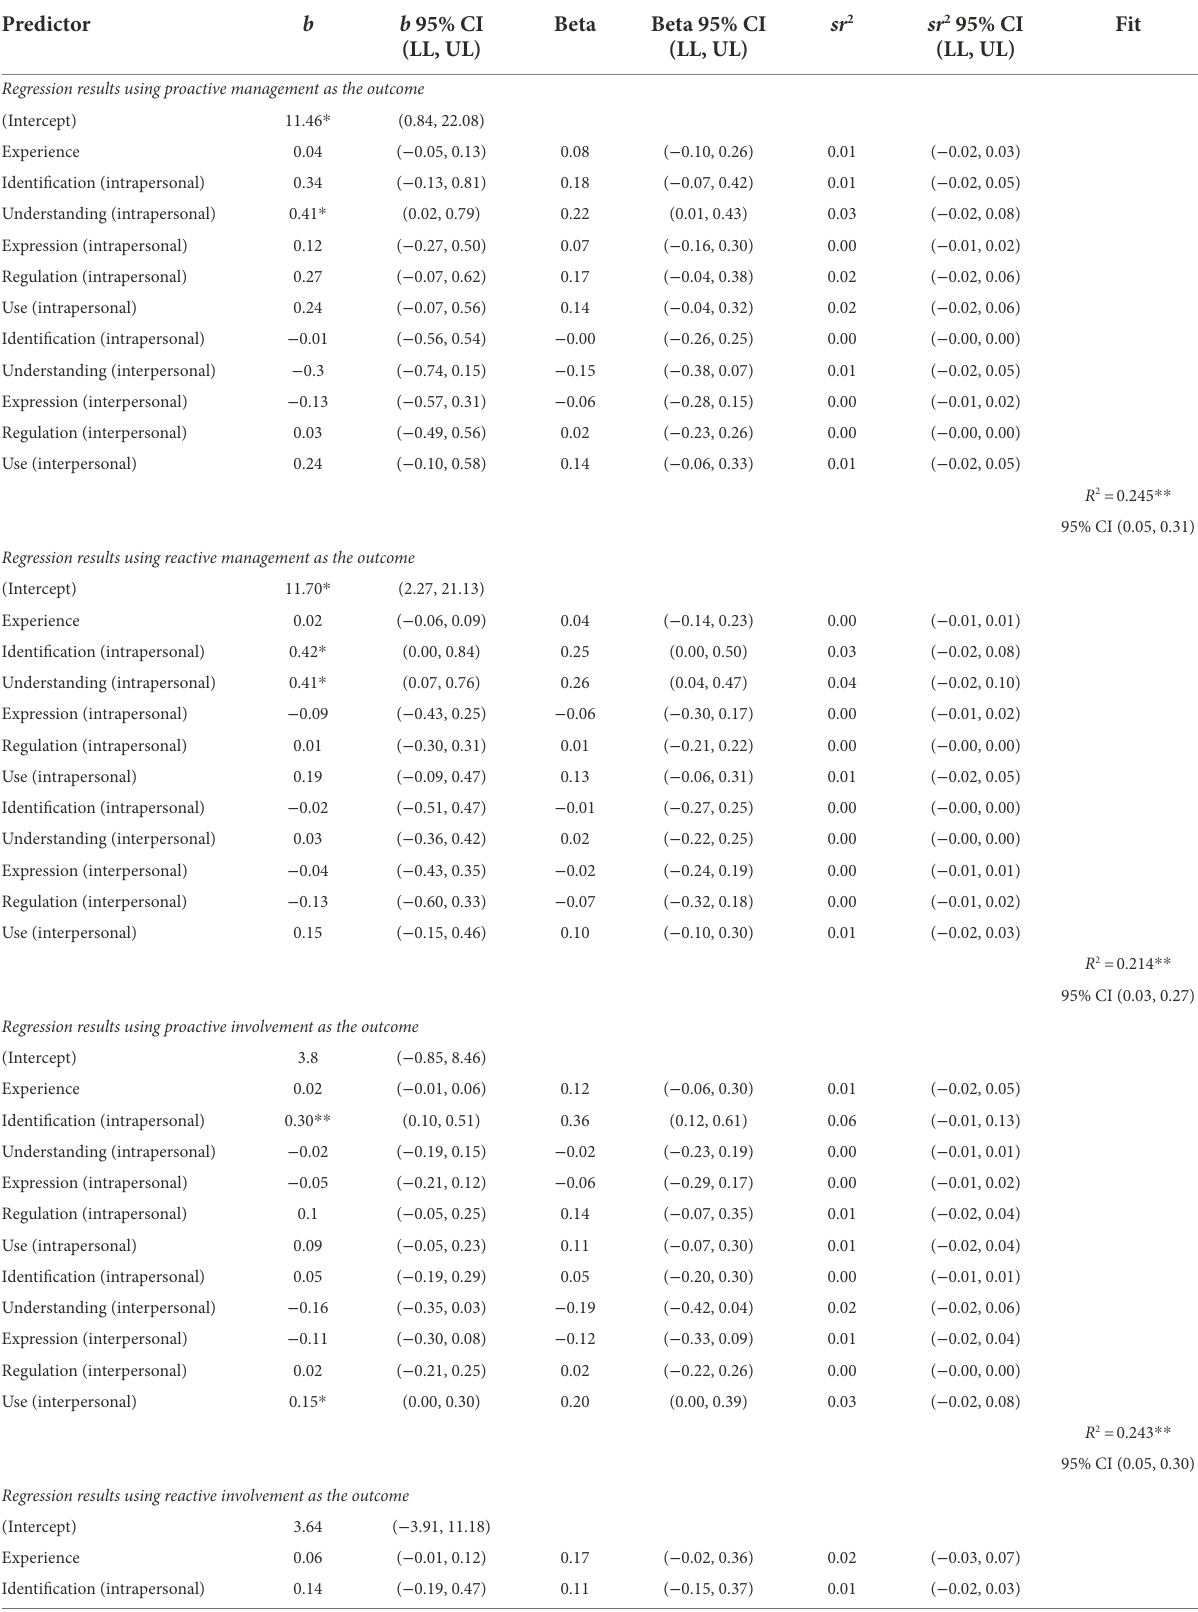
TABLE 2 Regression results using the four dimensions of perceived self-efficacy in behavior management as outcomes, with number of year of experience and the 10 dimensions of emotional competencies as independent variables. Predictor b b 95% CI